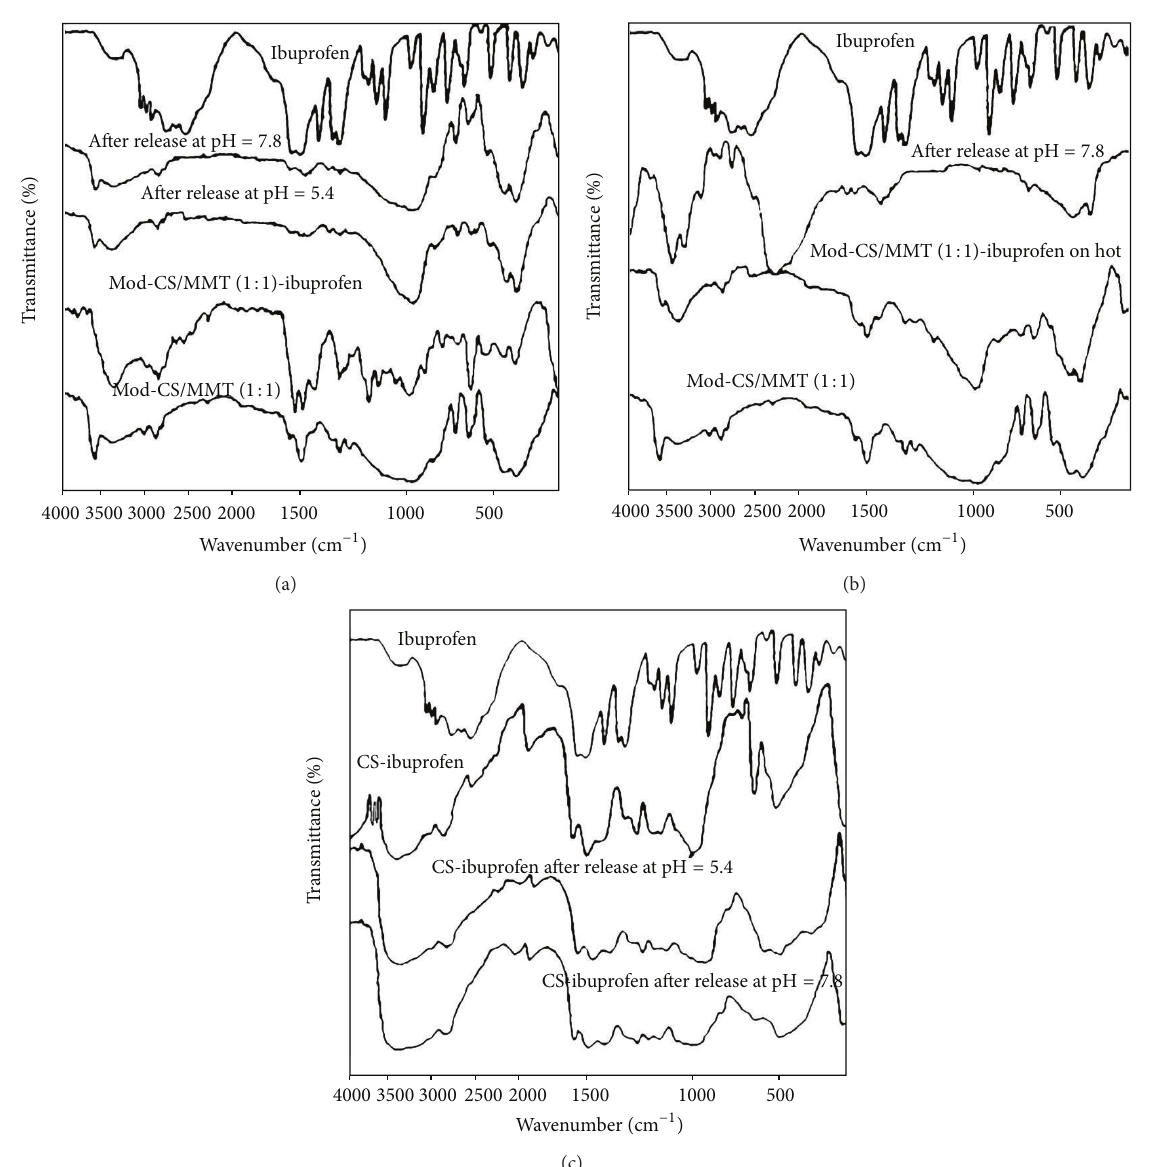
Figure 3: IR spectra in the region 4000–400 cm −1 of (a). Na-MMT, CS, mod-CS, mod-CS/MMT (1:1), ibuprofen, mod-CS/MMT—ibuprofen on cold. (b) Na-MMT, CS, mod-CS, mod-CS/MMT (1:1), Ibuprofen, mod-CS/MMT—Ibuprofen on hot. (c). Ibuprofen, CS, CS/ibuprofen and after release at pH = 5.4 and